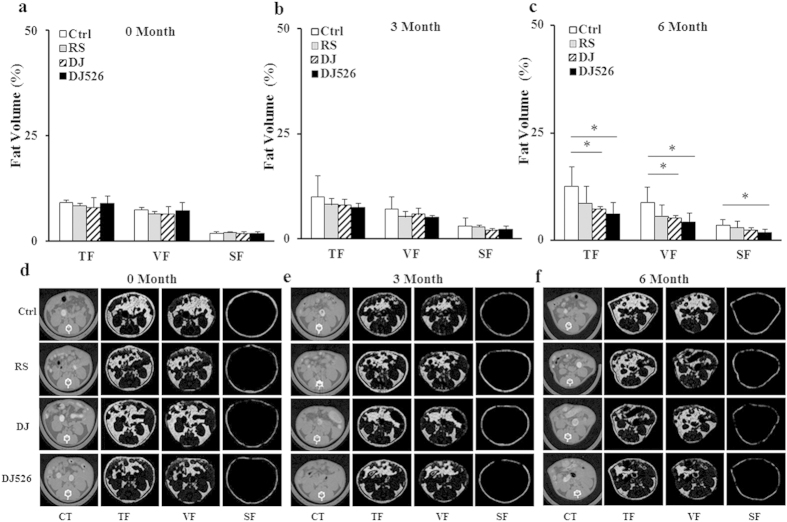
The effects of the resveratrol-enriched rice DJ526 on changes in abdominal fat content with age progression.The control (Ctrl) mice fed a NFD in which the carbohydrate source was corn starch and sucrose; The resveratrol (RS) mice fed a NFD in which the carbohydrate source was corn starch and sucrose except containing resveratrol; Dongjin (DJ) mice fed a NFD in which the corn starch and sucrose were replaced with Dongjin rice; DJ526, mice fed a NFD in which the corn starch and sucrose were replaced with the resveratrol enriched rice DJ526. The resveratrol concentration in DJ526 and RS groups was 0.69 μg/g each, and not detected in Ctrl and DJ groups. (a–c) Comparative analysis of the mice abdominal fat volume measured by in vivo micro-CT image analysis at 0 month (a), 3 month (b) and 6 month (c). (d–f) The representative micro-CT image used for abdominal fat analysis at 0 month (d), 3 month (e) and 6 month (f). The values represent the mean ± s.d. (n = 20). An unpaired Student’s t-test was used for the statistical analysis; *p < 0.05. TF, total fat; VF, visceral fat; SF, subcutaneous fat.